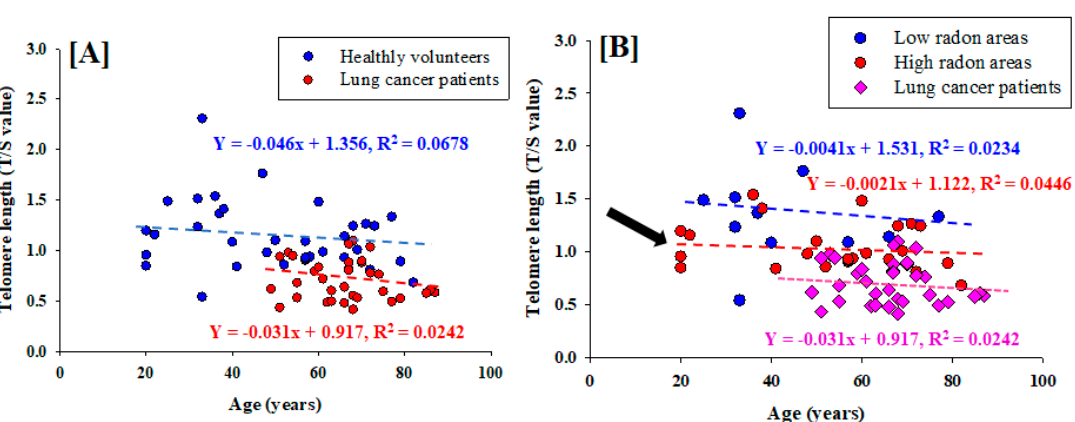
Figure 5. Correlation between age and relative telomere length (T/S value) in peripheral blood leukocytes in lung cancer patients and healthy controls. ( A ) Telomere length among lung cancer patients and healthy controls. ( B ) Telomere length among lung cancer patients and healthy controls with respect to low- and high level environmental radon areas.